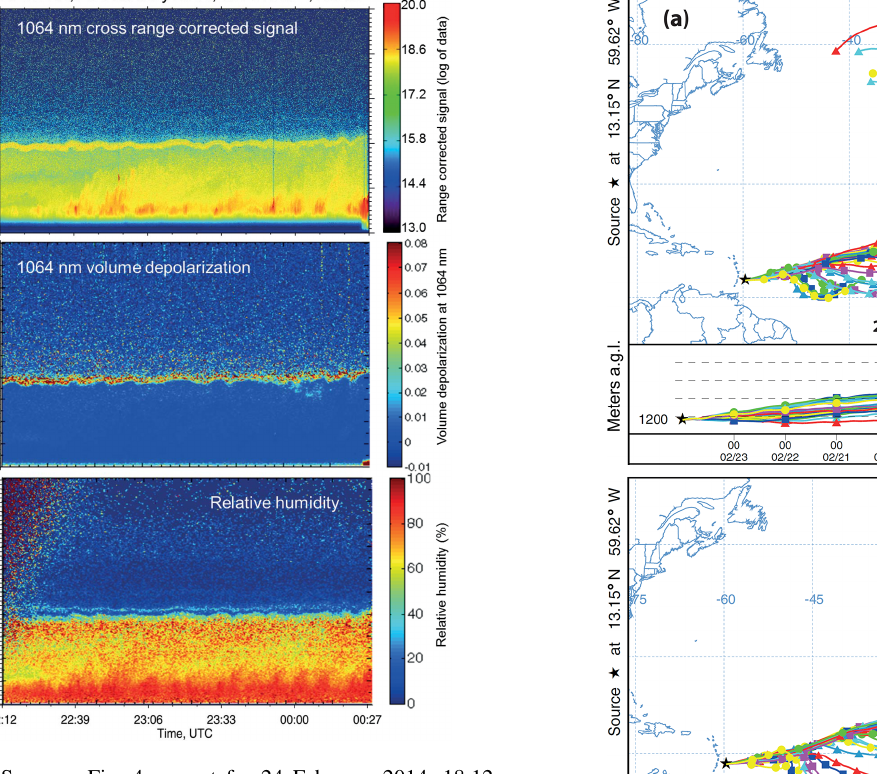
Figure 5. Same as Fig. 4, except for 24 February 2014, 18:12– 20:27 local time. The MAL top is again close to 2km height. The convective MBL reaches to about 800m height and permanently pushes sea salt particles into the upper part of the MAL. RH is high throughout the MAL (and thus depolarization ratio caused by spherical, wet marine particles is low). Only at MAL top do dried marine particles cause a thin layer of enhanced cross-polarized sig- nal ( a 10s temporal, 7.5m vertical resolution) and depolarization ratio (b) . Daytime noise is visible in the RH (c) in the first half hour after sunset at 22:06UTC. Panels (b) and (c) are based on the depolarization ratio and RH profile values averaged over 30s and vertically smoothed over 22m (b) and 52m (c) .